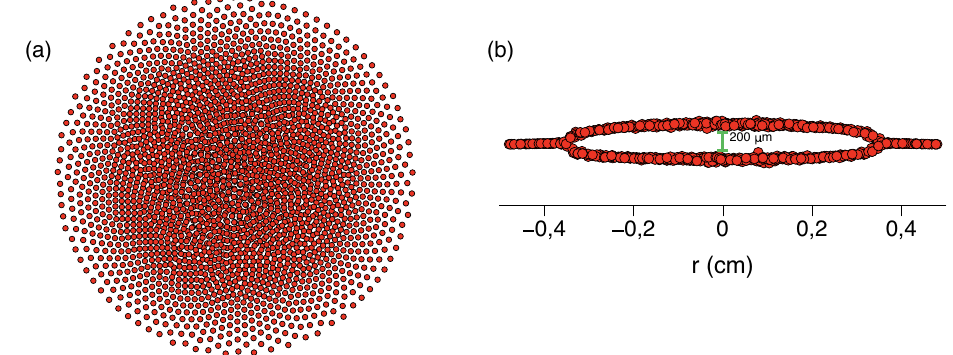
Figure 4. Typical ( a ) top and ( b ) side view of the dusty plasma structure in MD simulations in this work.